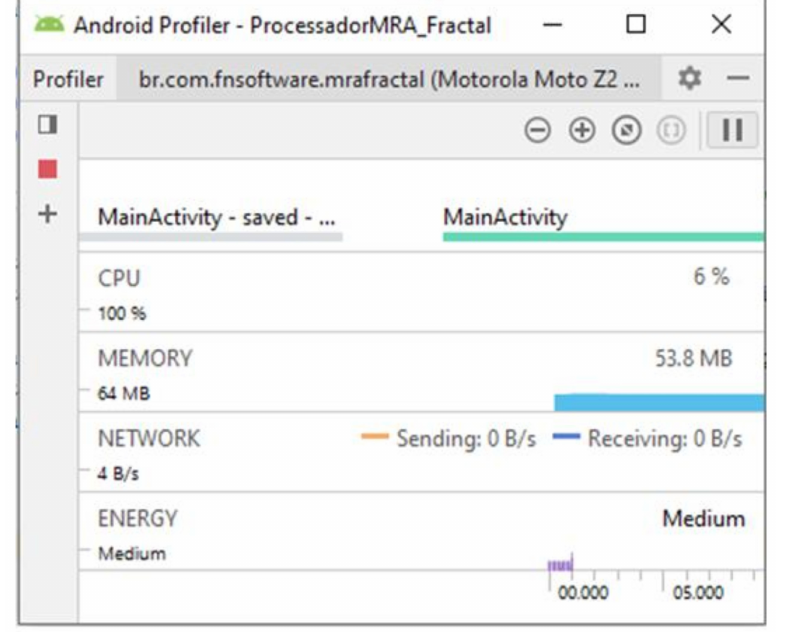
Figure 32. Overall app performance—FD-based